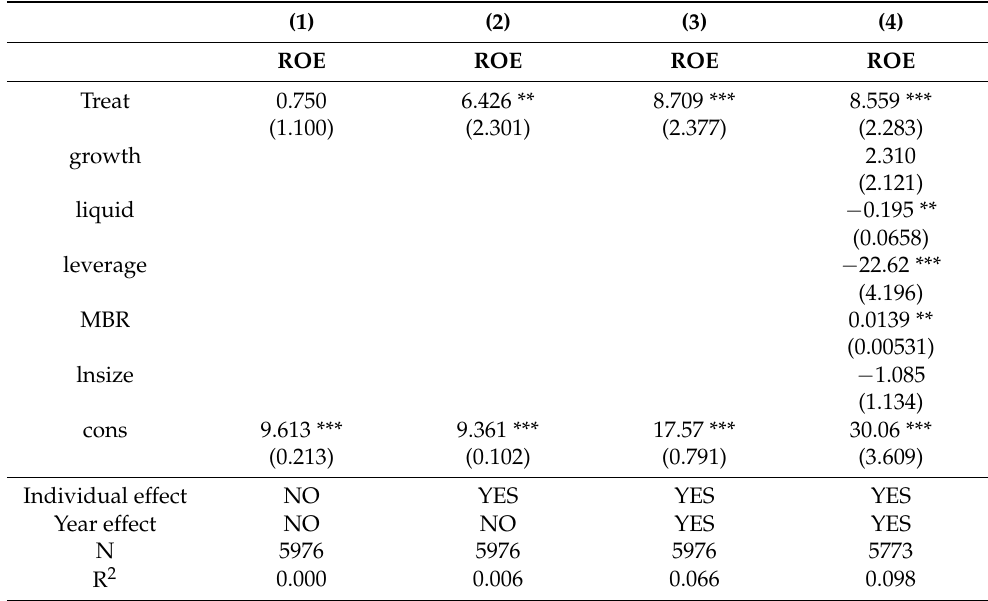
Table 7. Robustness test of replacement control